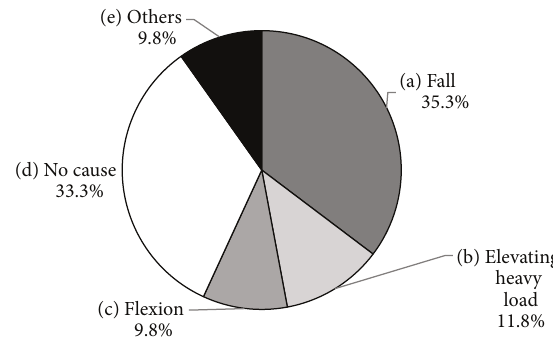
Figure 2: Onset of LBP. Apparent injury cases amounted to 47.1% (a + b), while no cause and light loading cases amounted to 52.9% (c + d +